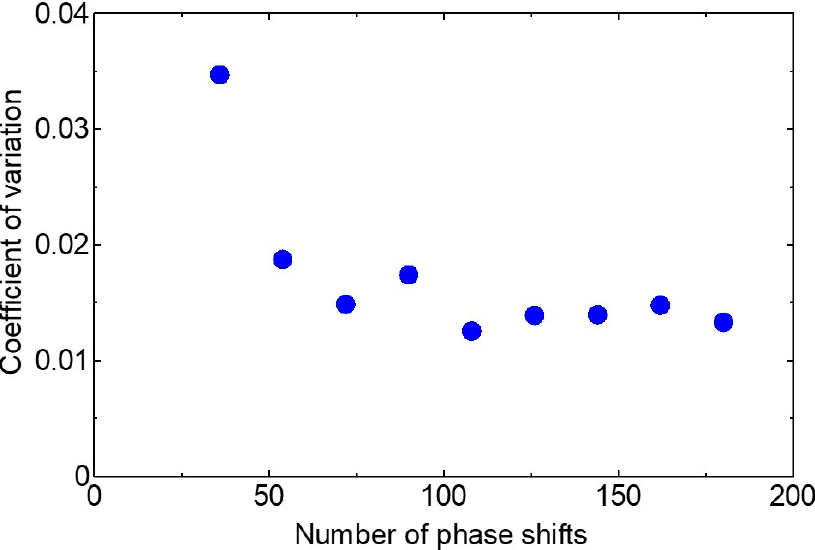
Figure 7. The relationship between the cofficient of variation of spectrum and the number of phase shifts after the improvement of the system.